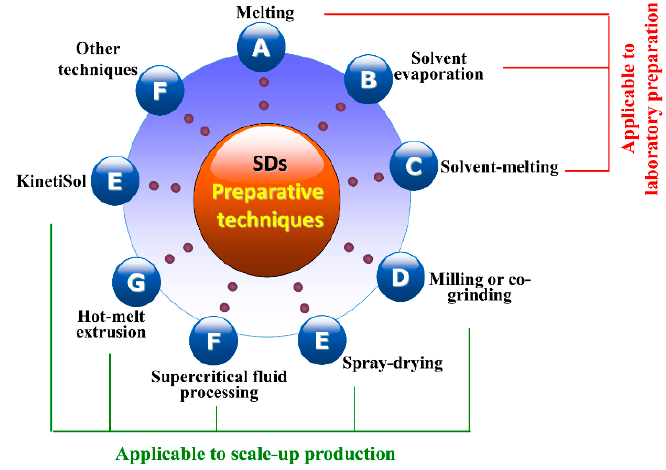
Figure 3. Commonly used preparative techniques for solid dispersions.